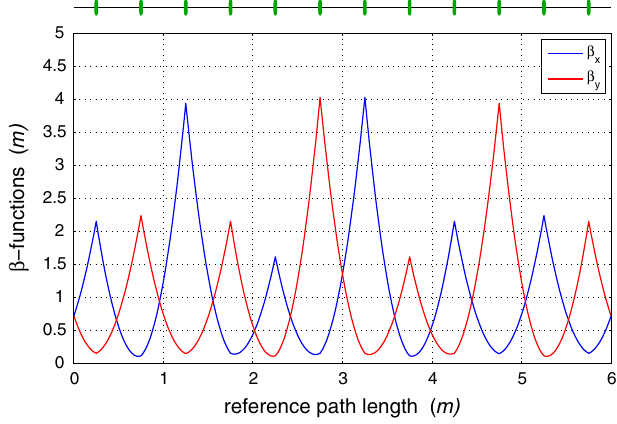
FIG. 3. Betatron functions along the phase advance scan beam ¼ (cid:8) ¼ 60 (cid:8) . line for (cid:8) x y